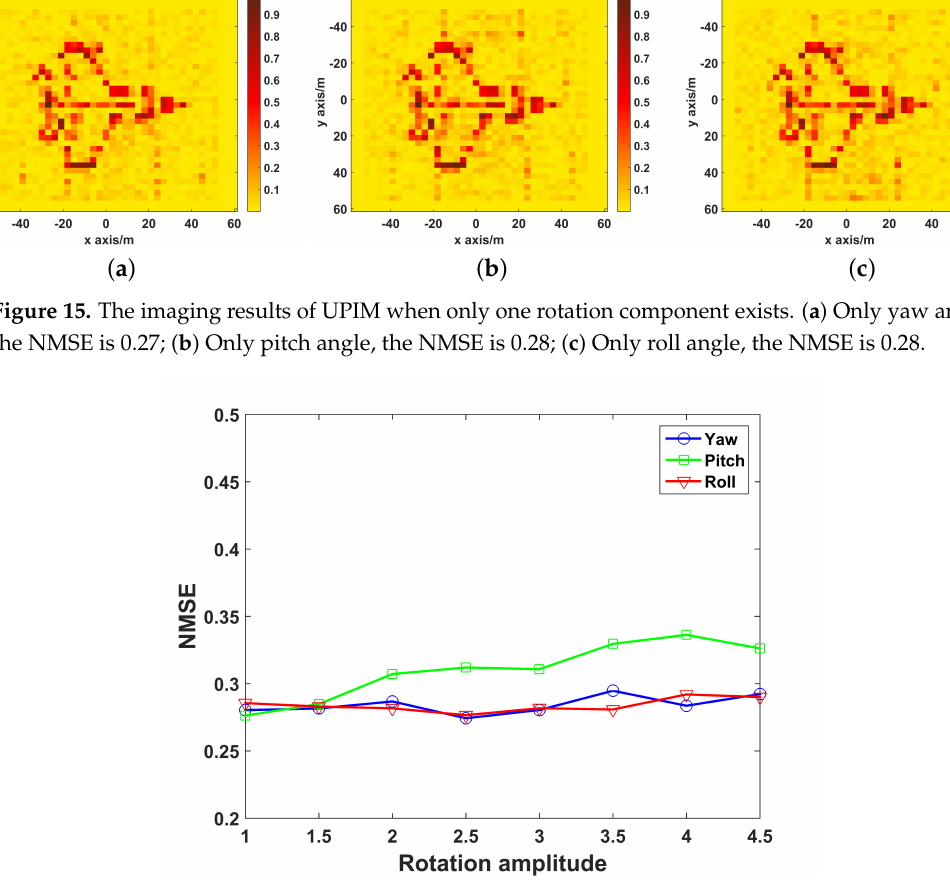
Figure 16. NMSE of the imaging results when only one rotation component exists at different